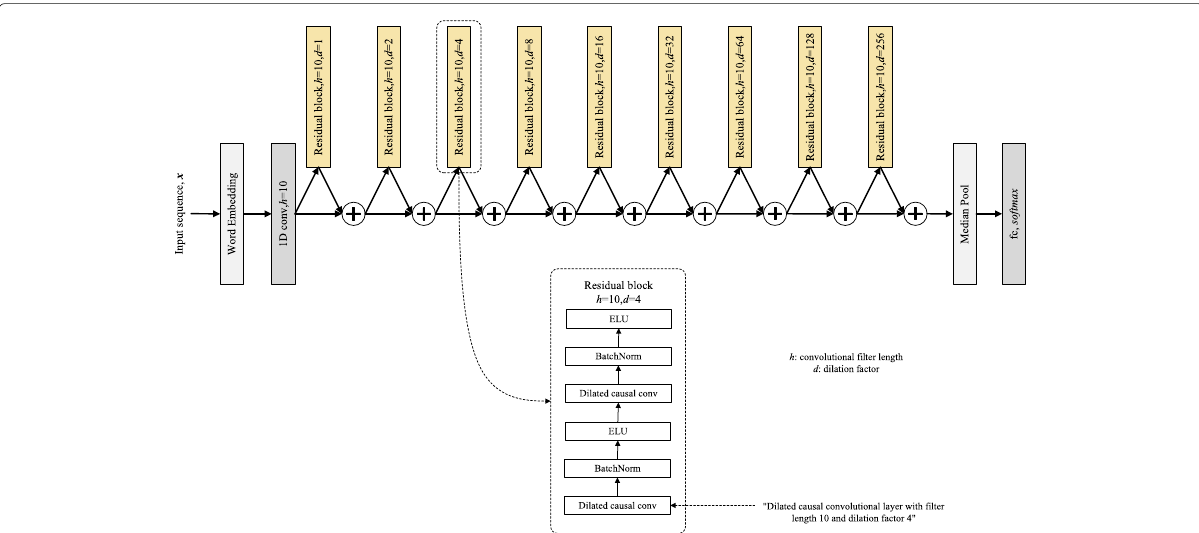
Fig. 7 The TCN structure for malware categorization. The first convolutional layer (in grey) is used for matching the embedding size and filter length, then some continuous residual blocks with different dilation factors are stacked (in